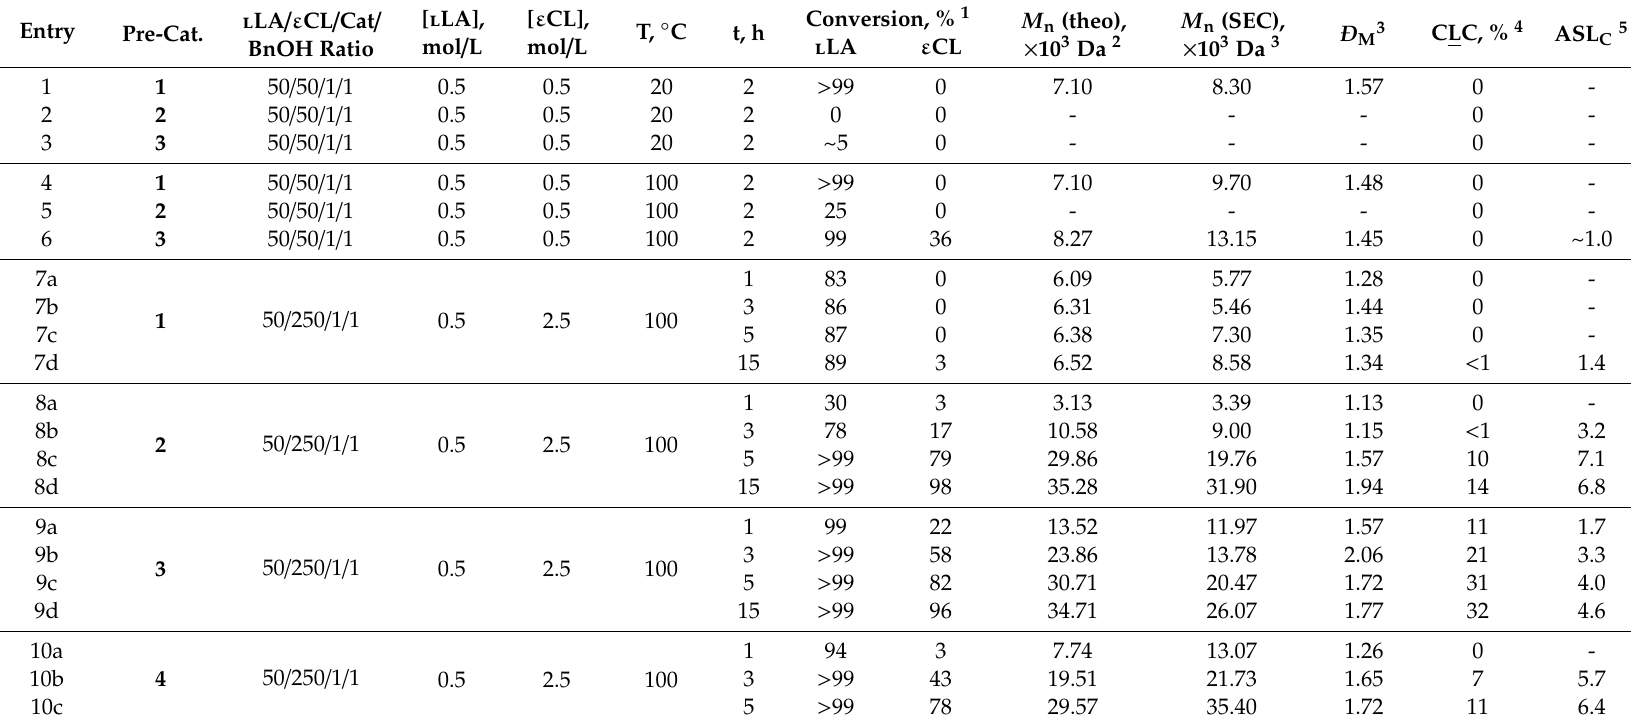
Table 2. LA / ε CL copolymerization results for complexes 1 – 3